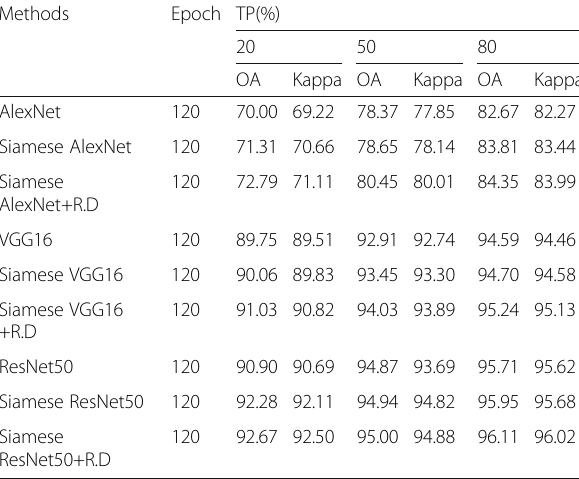
Table 2 Comparison of OA (%) and Kappa (%) on NWPU- RESISC45 data set